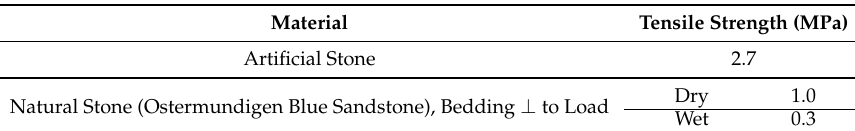
Table 3. Tensile strength of the repair material and of the Ostermundigen